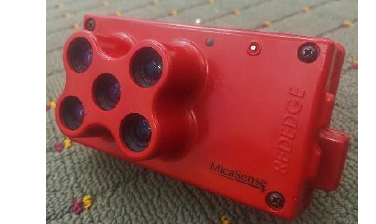
Figure 1: RedEdge multispectral camera.